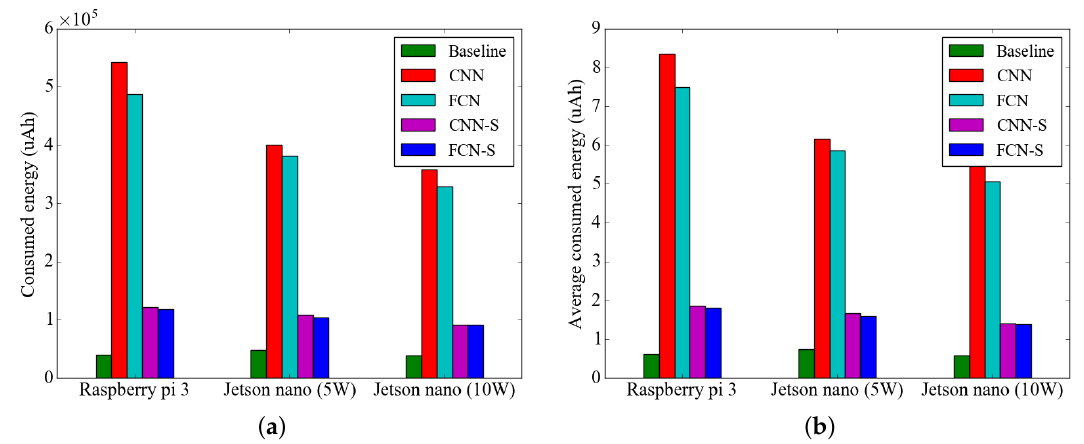
Figure 9. Results of measurements of energy consumed by the activity recognition methods on the embedded platforms: ( a ) Total energy consumed ( b ) Average energy consumed per sample.